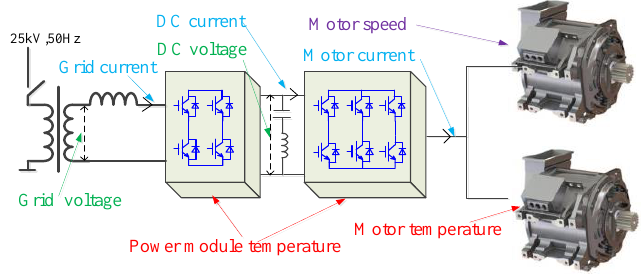
Figure 1. Traction system collected information.